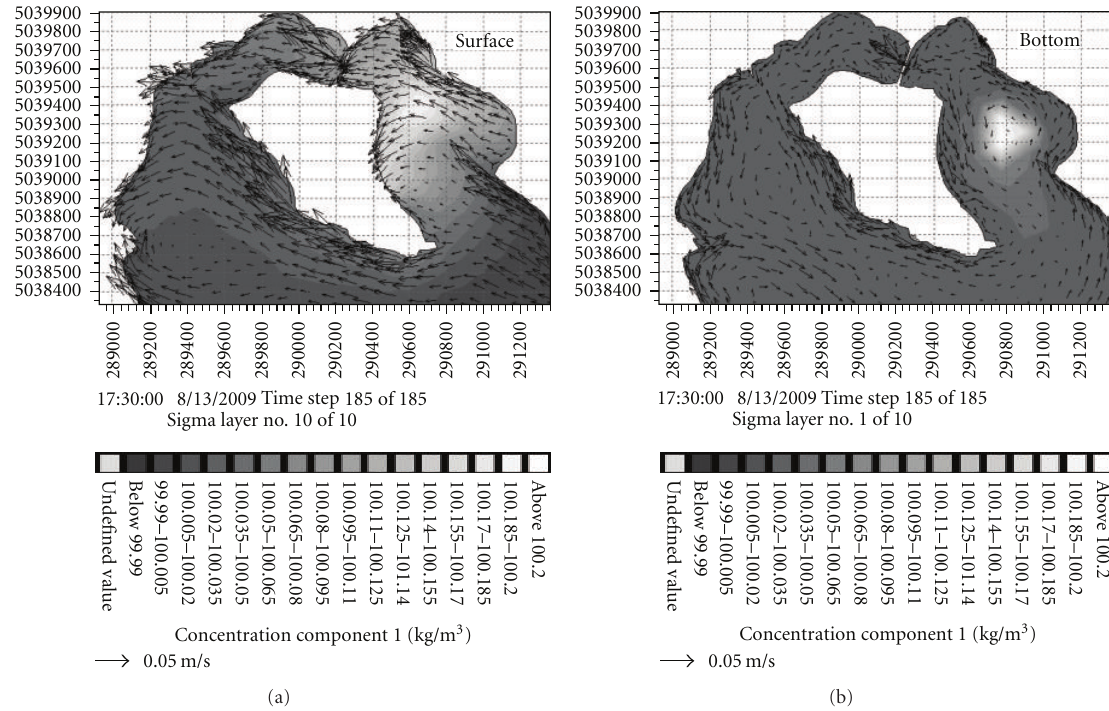
Figure 20: Simulated flow patterns in the causeway area, driven by 10 m/s constant east wind under the causeway with a single opening. patterns in Figure 20. The surface flows, as expected,